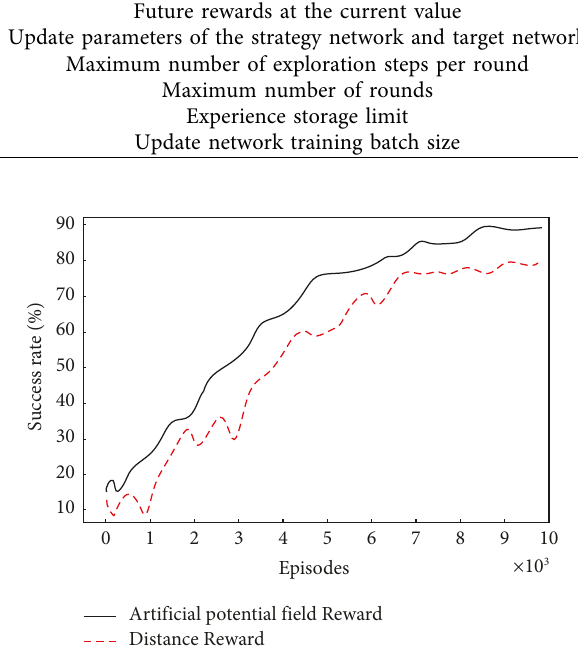
Figure 4: Total reward value per episode. Figure 5: Change trend of the overall success rate.